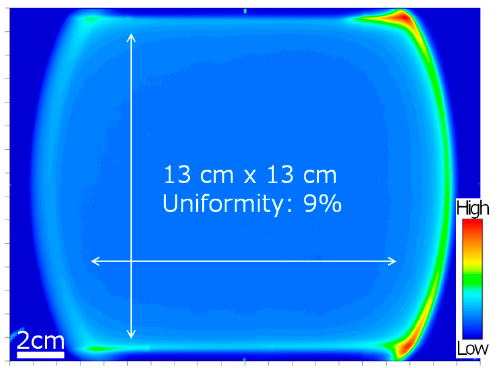
Figure 11. Two-dimensional relative intensity distributions obtained from the optical density distribution of a Gafchromic film HD-810 (Ashland Inc., Covington, Kentucky, USA). The film was irradiated with the 385 MeV 40 Ar beam formed using octupole magnets at the LB beamline.